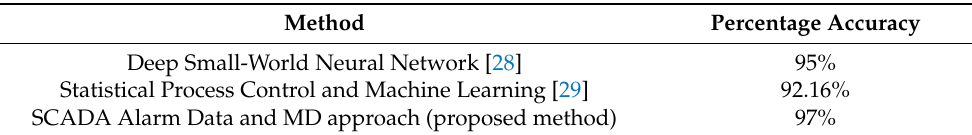
Table 7. Efficiency comparison of proposed method to other